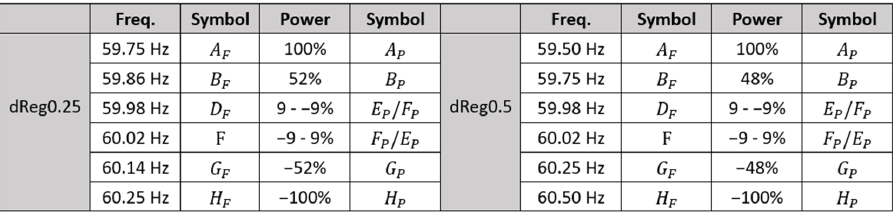
Figure 1. The response curve of the dReg mode.